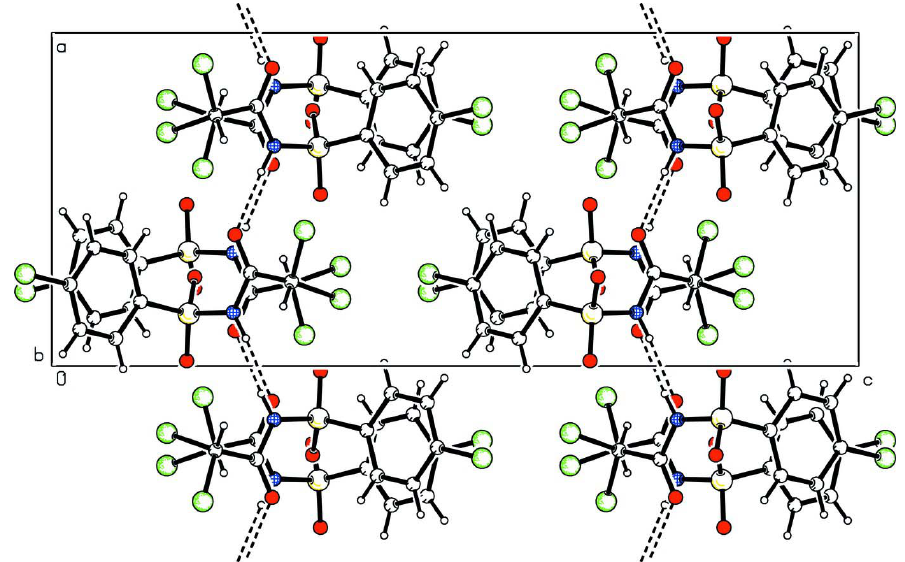
Figure 2 Molecular packing of the title compound with hydrogen bonding shown as dashed